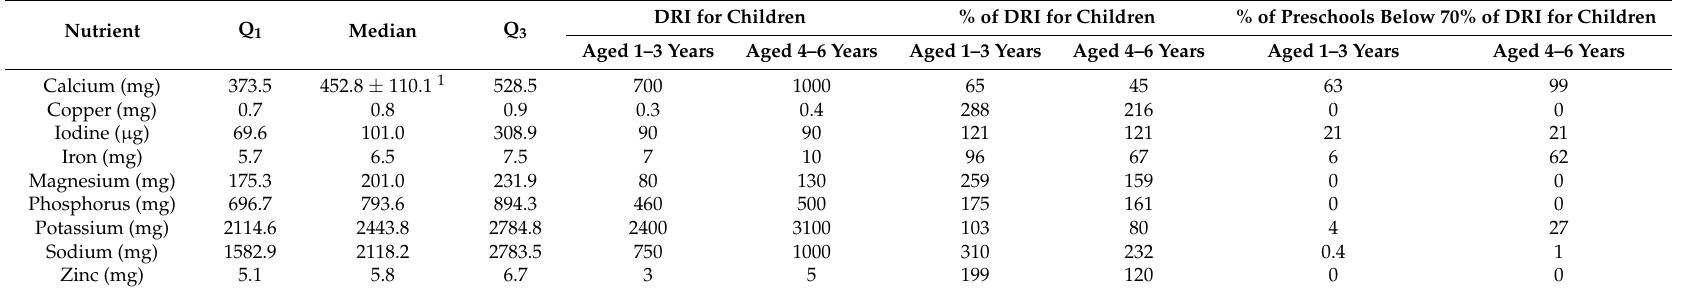
Table 3. Minerals provided in preschools ( n = 270) menus per child per day and the age-specific dietary reference intake (DRI).